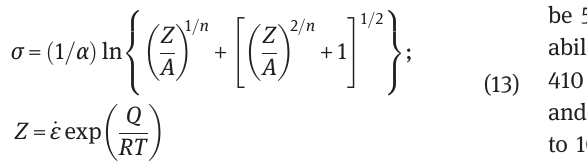
Table 2: The coefficients for the polynomial used to model the material parameters of AISI 410 steel.